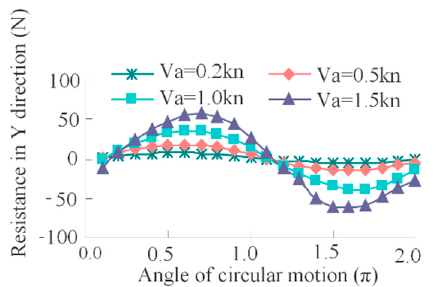
Figure 19. Y-directional fluid resistance of the underwater robot.